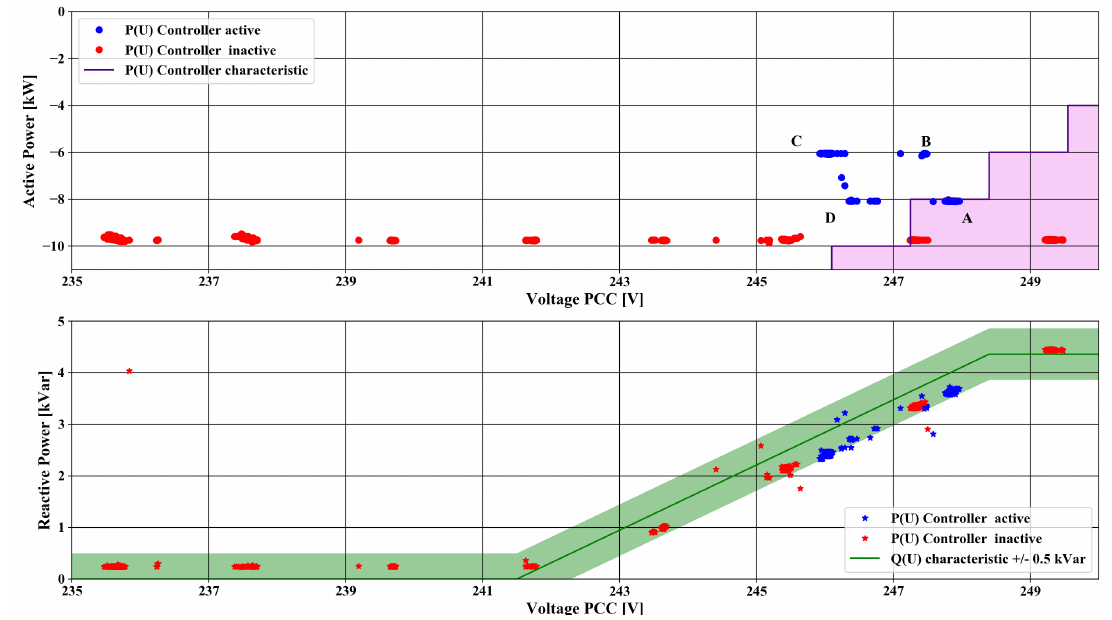
Figure 14. Comparison of the coordinated P(U) control governed by the EDCC and the Q(U) control of the inverter. Control characteristics are represented by the purple and green lines, respectively.